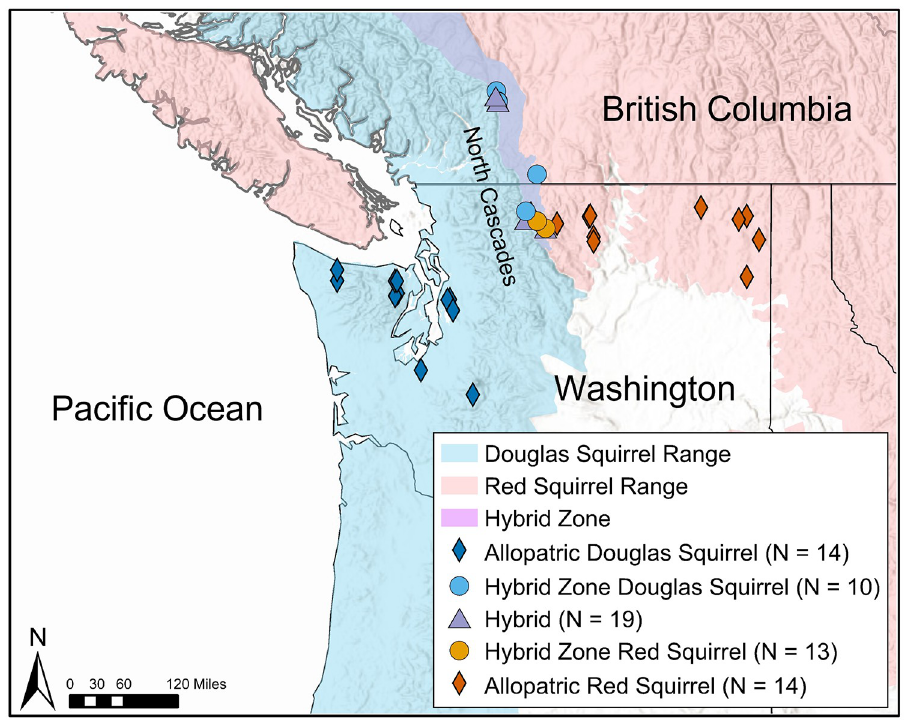
Fig 1. Map indicating approximate range boundaries for Douglas squirrels (blue), red squirrels (red), and the hybrid zone (purple) in the North Cascades region. Range shapefiles developed from published descriptions [49, 50] by A.S. Chavez. Symbols indicate sampling localities. Some specimens within the hybrid zone geographically overlap, see S1 Table for complete specimen details. Basemap reprinted from Terrain With Labels under a CC BY license, with permission from ESRI, original copyright